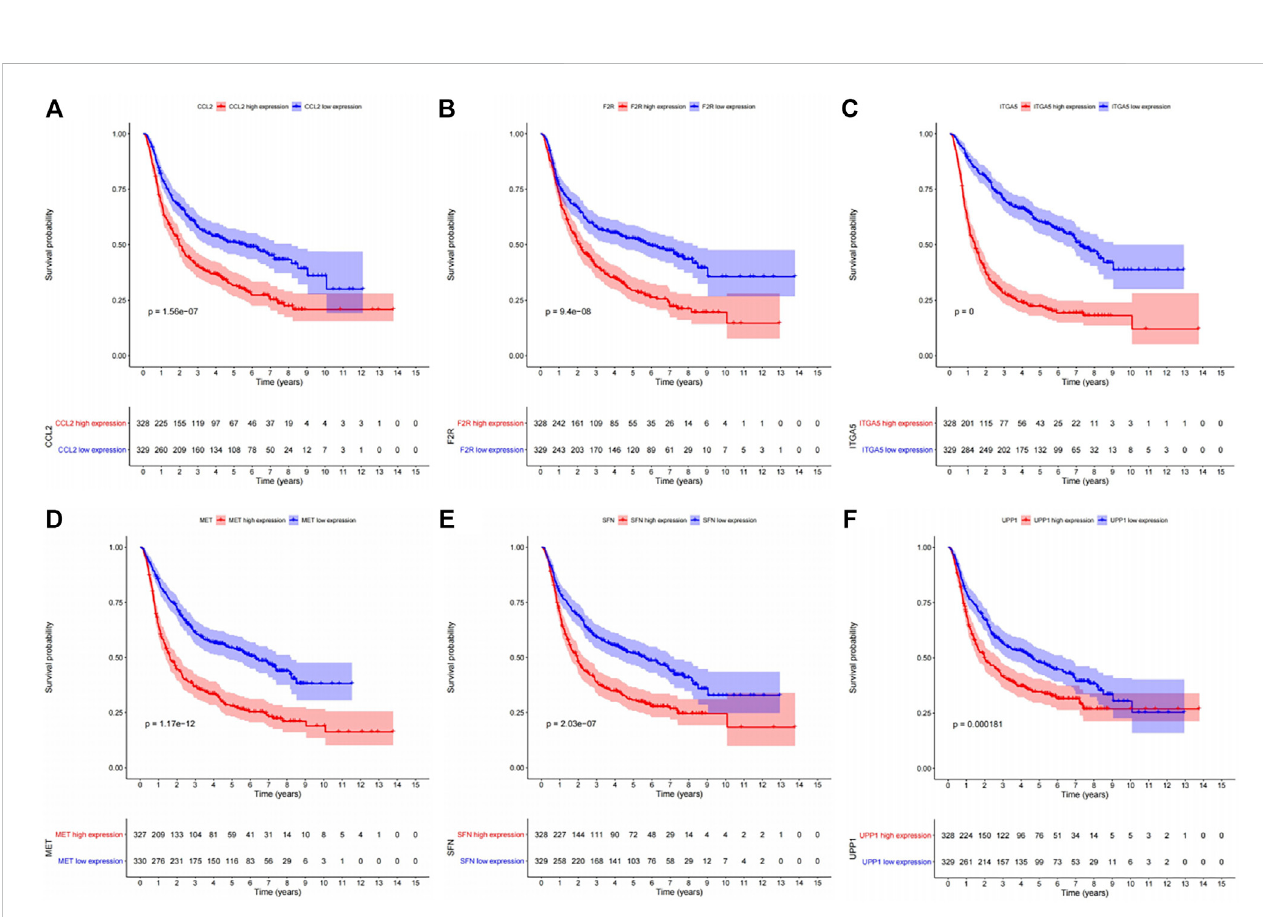
FIGURE 5 Kaplan – Meier survival analysis between the high- and low-expression groups of the six genes with signi fi cant survival differences in the CGGA dataset. (A) CCL2. (B) F2R. (C) ITGA5. (D) MET. (E) SFN. (F) UPP1.